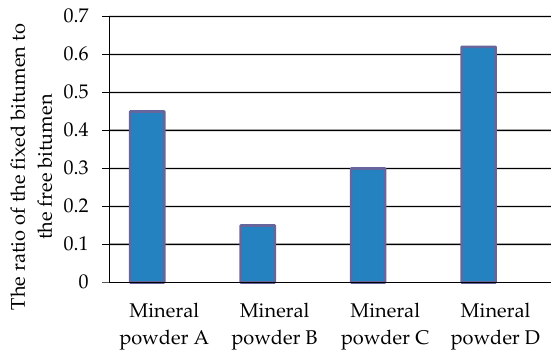
Figure 8. Effect of the meso powder characteristics of the mineral filler on the fixed bitumen–free bitumen ratio under the same mineral filler content.